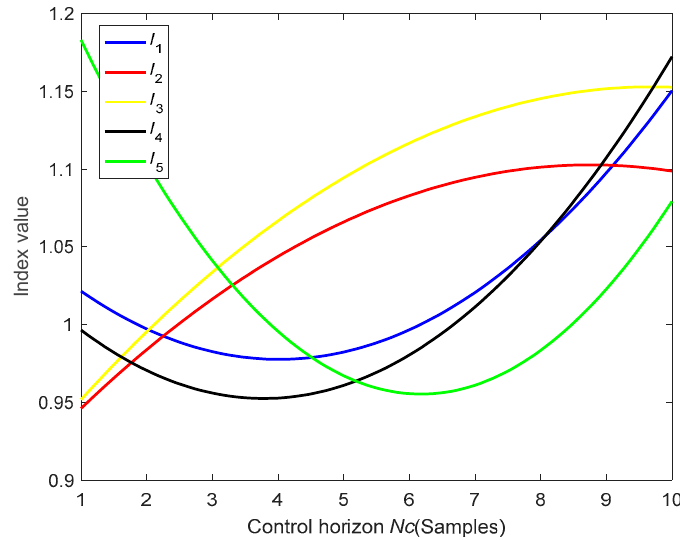
Figure 6. Optimization index for different control horizon values.